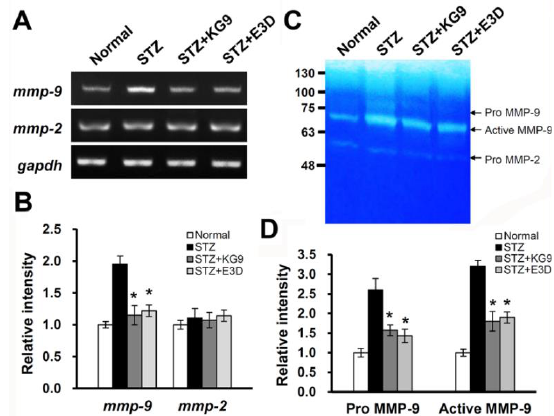
Figure 4. GS-KG9 and GS-E3D inhibit the expression and activity of MMP-9 in the hippocampus of STZ-induced diabetic rats. At 28 d after GS-KG9 and GS-E3D (300 mg/kg) treatment, hippocampal tissue was prepared, as described in the Materials and Methods section. ( A ) RT-PCR of mmp-2 and mmp-9 . ( B ) Densitometric analysis of RT-PCR ( n = 3 rats/group). ( C ) Gelatin zymography. ( D ) Densitometric analysis of zymography ( n = 3 rats/group). Note that GS-KG9 and GS-E3D significantly inhibit MMP-9 mRNA expression and activation in hyperglycemia-induced rats as compared to STZ control. Data are expressed as the mean ± SD ( n = 5 rats/group). * p < 0.05 vs. STZ control.